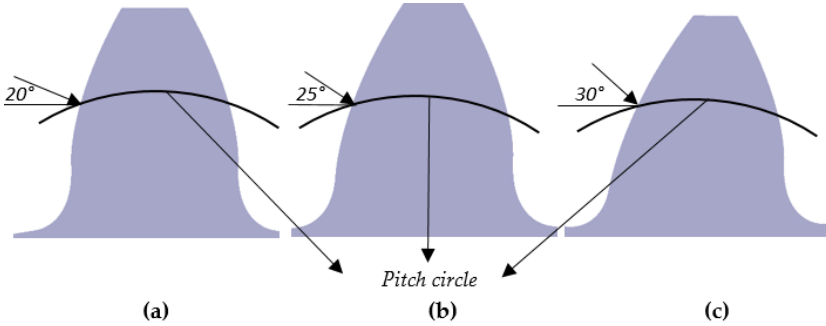
Figure 2. Spur gear tooth with different DSPAs: ( a ) 20 ◦ , ( b ) 25 ◦ , ( c ) 30 ◦ . The material of the tooth-rim and hub regions of hybrid gears are assigned as steel with isotropic properties. Elasticity modulus € and Poisson’s ratio ( υ ) are defined as 210 GPa and 0.3, respectively. CFRP material on the web region of the gear is modeled as an